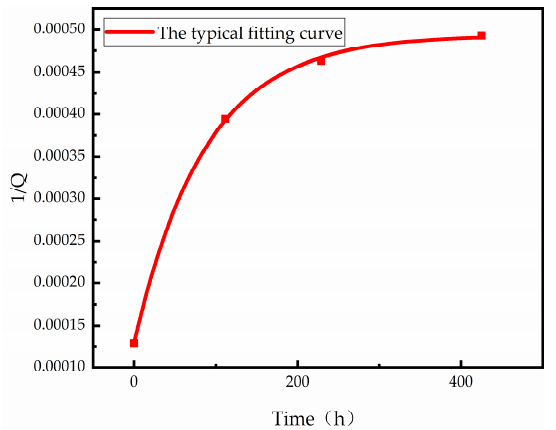
Figure 4. Q-factor degradation fitting curve of M4 sample at 105 °C.